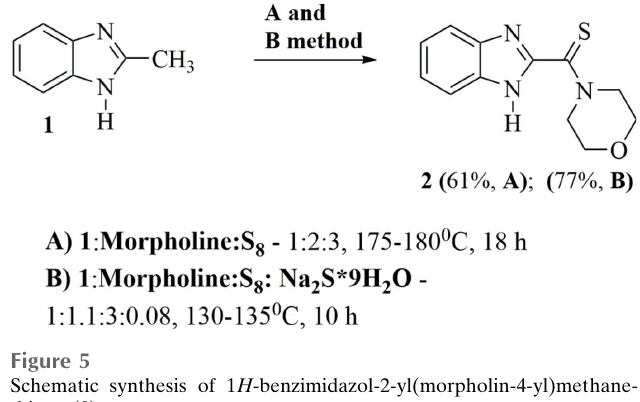
Figure 5 Schematic synthesis of 1 H -benzimidazol-2-yl(morpholin-4-yl)methane- thione ( 2